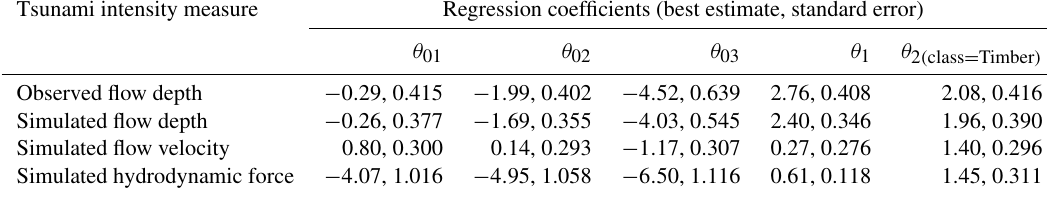
Table E1. Regression coefficients for the 2018 Sunda Strait tsunami fragility curves based on DB_Sunda2018.